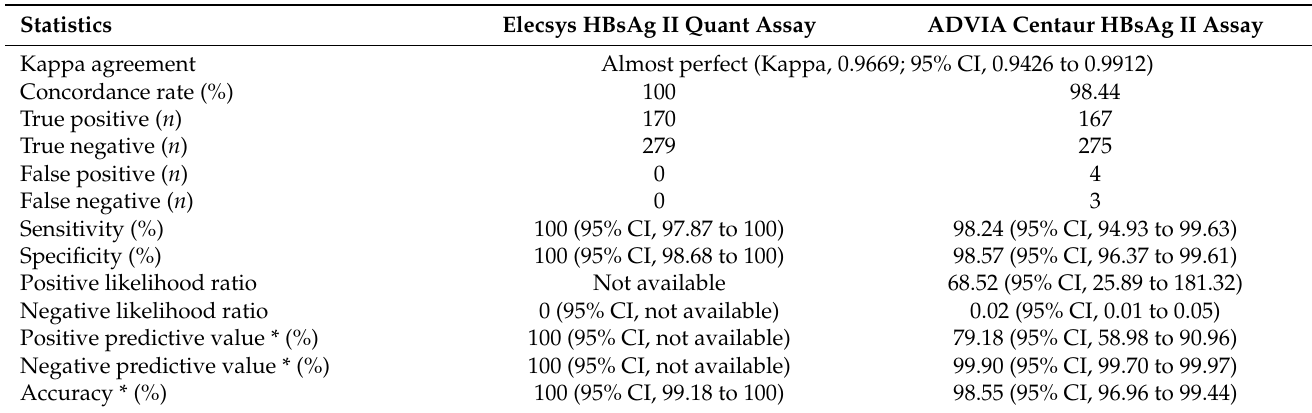
Table 3. Diagnostic performance statistics of Elecsys HBsAg II Quant and ADVIA Centaur HBsAg II assays in 449 equivocal